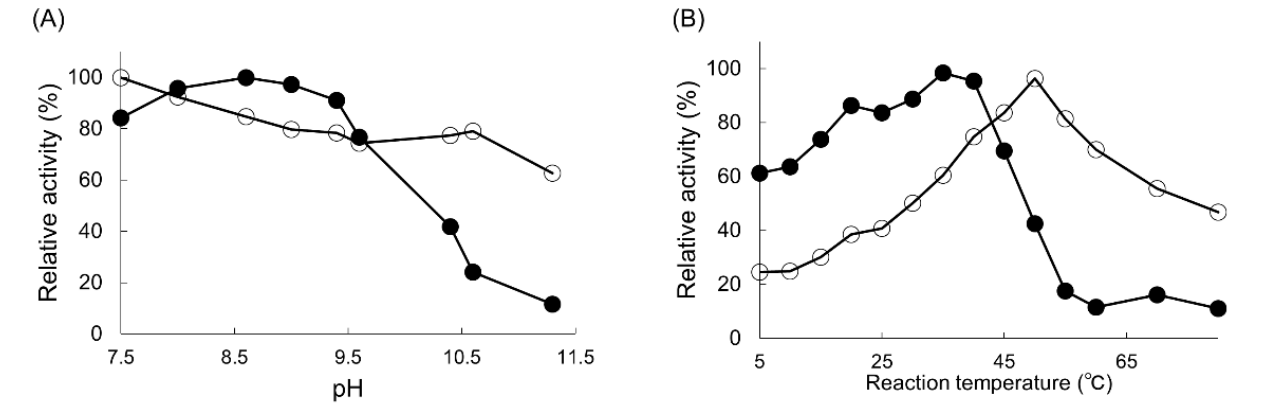
Figure 1. Effects of temperature and pH on enzymatic activity for synthesis of PPEA ( ● ) and aceto- phenone ( ○ ). ( A ) The reaction was performed at 20 °C for 5 min using 150 mM ( R )-MBA of pH 7.5 – 11.3) and 2 U of variant pkDAO. ( B ) The reaction was performed at 5 – 80 °C for 5 min using 150 mM ( R )-MBA of pH 9.0 and 2 U of variant pkDAO. The amounts of imine and acetophenone were meas- ured using high-performance liquid chromatography.